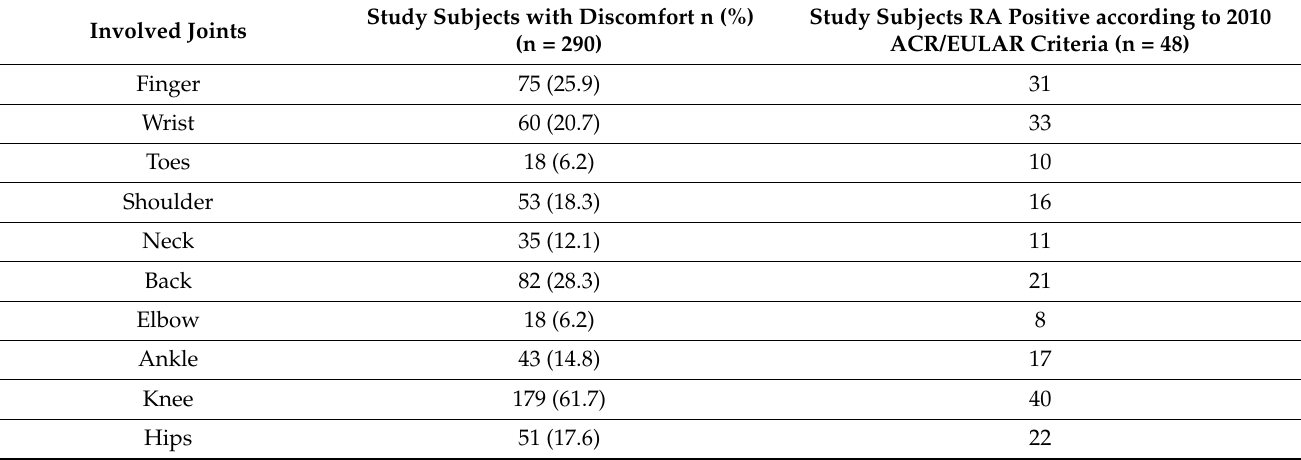
Table 2. Distribution of joints’ involvement for the study subjects.